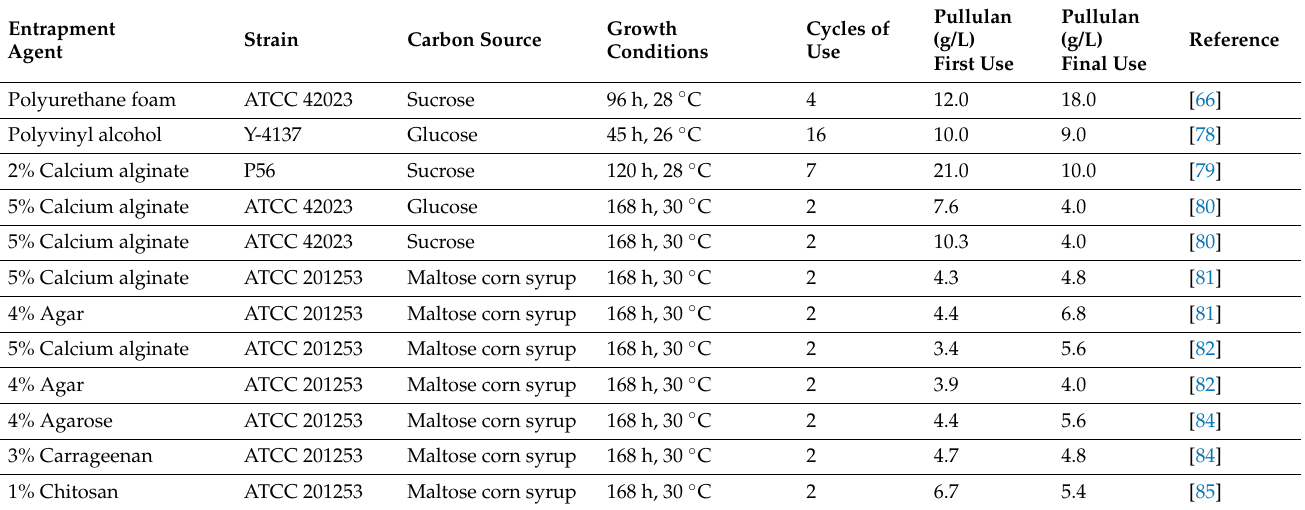
Table 2. Growth conditions and maximum pullulan production by Aureobasidium pullulans strains immobilized by